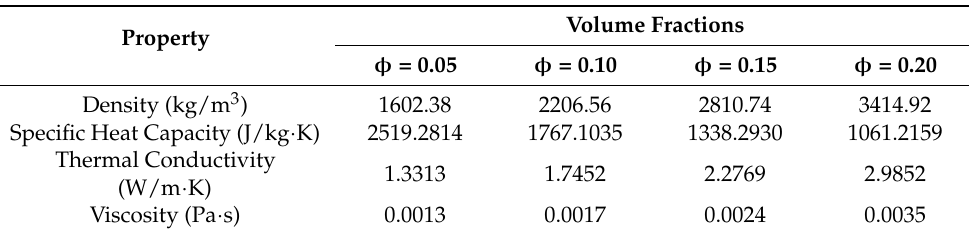
Table 5. Thermo-physical properties of Ag-MgO (50:50 vol.%)/Water hybrid nanofluid at various volume fractions.